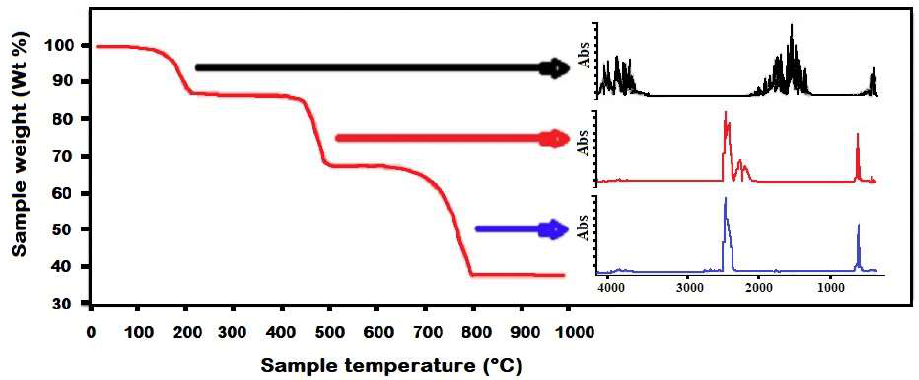
Figure 2. TG-FTIR analysis of a three-step decomposition example.